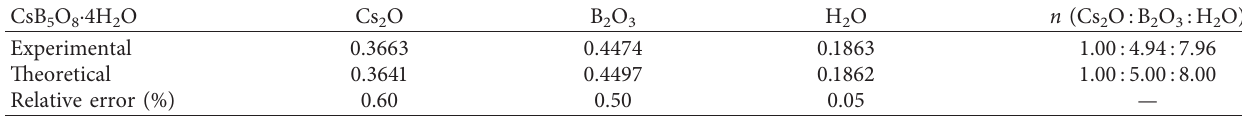
· 4H 5 O 8 2 O in mass fraction